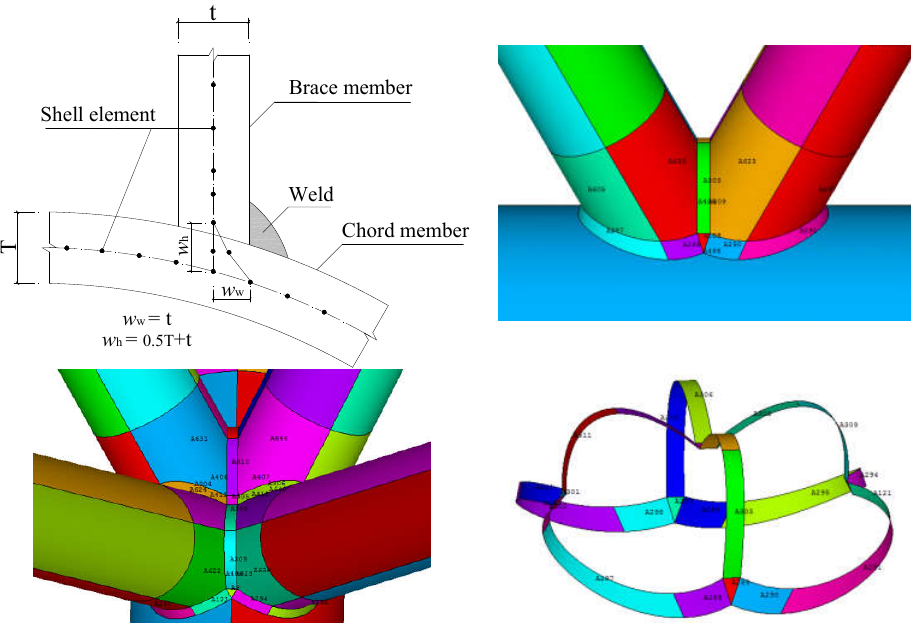
Figure 15. Weld modelling.